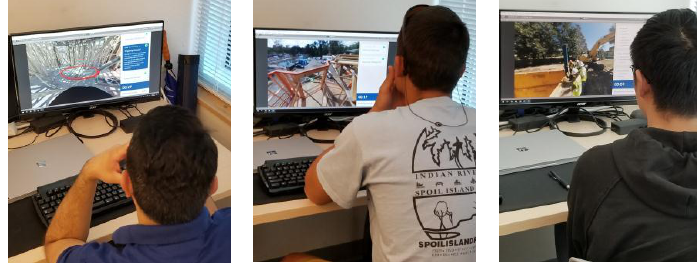
Figure 8. Subjects using the training platform.